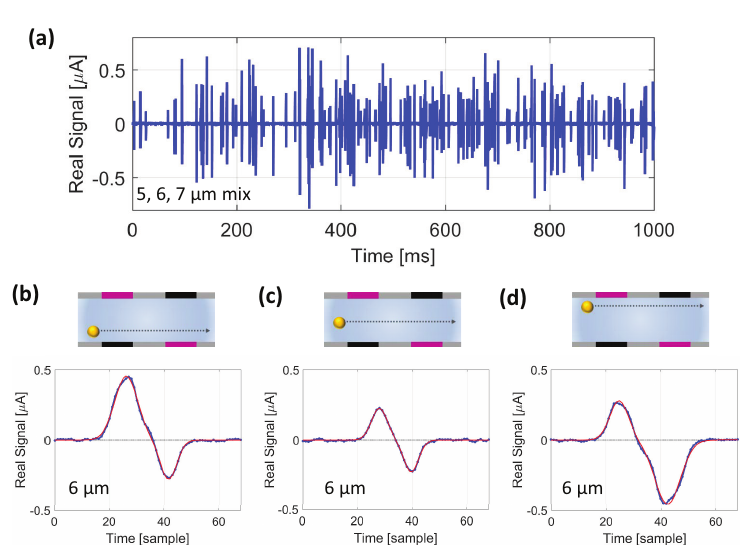
Figure 4. Facing electrode chip operated using the novel wiring scheme. ( a ) Portion of the synthetic data stream F new , relevant to a mixture of 5, 6, and 7 µ m beads. ( b – d ) Exemplary events (blue curves) mix taken from the data stream in ( a ) and relevant to 6 µ m diameter beads traveling ( b ) close to the bottom of the channel, ( c ) through the middle of the channel, and ( d ) close to the top of the channel. Fitting templates are also shown (red curves).